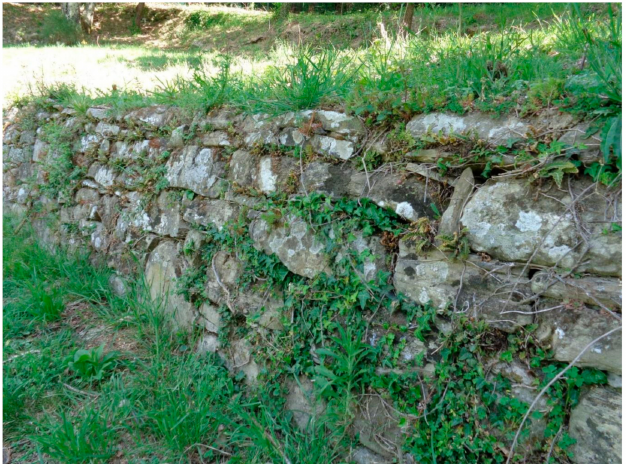
Figure A1. Damage class 1—Regular.